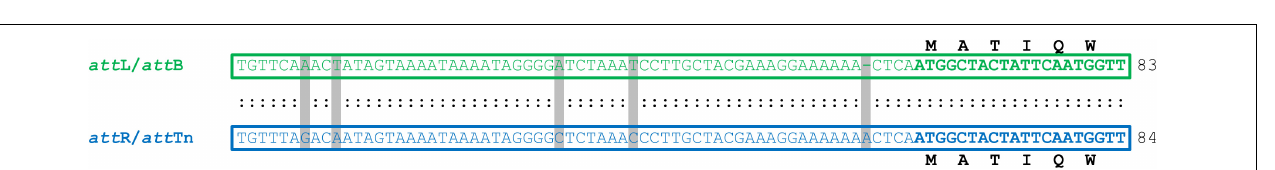
FIGURE 1 | Tn 5253 excises from pneumococcal chromosome producing a circular form and a reconstitution of att B insertion site. In the circular form of Tn 5253 the left and right ends are joined by att Tn which is identical to att R whereas the reconstituted att B site is identical to att L. att sites are represented as filled rectangles, chromosomal genes as open arrows, Tn 5253 as a yellow bar. Arrowheads represent PCR primers used for circular form (dark gray) and reconstituted att B site (light gray) detection.